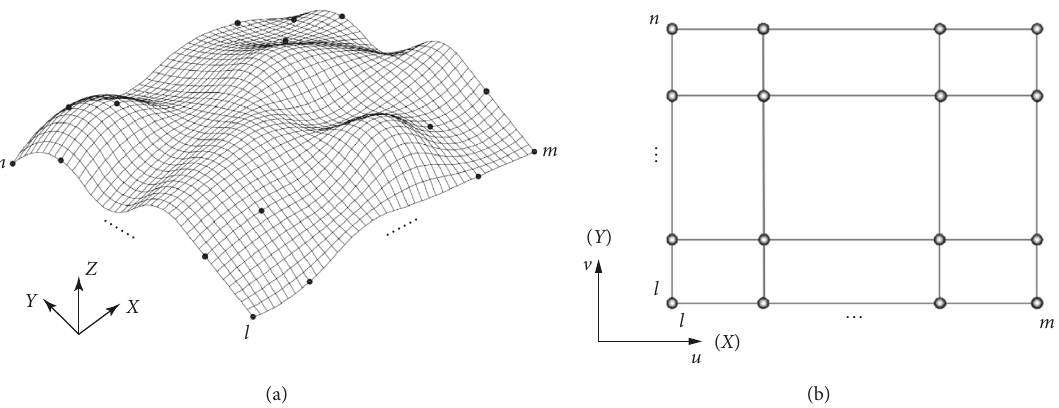
Figure 1: Example of NURBS surface. (a) NURBS surface. (b) Corresponding grid of control points.